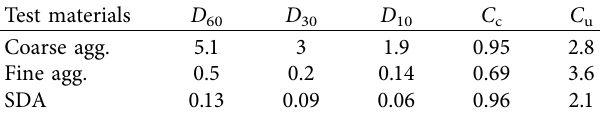
Table 7: Gradation